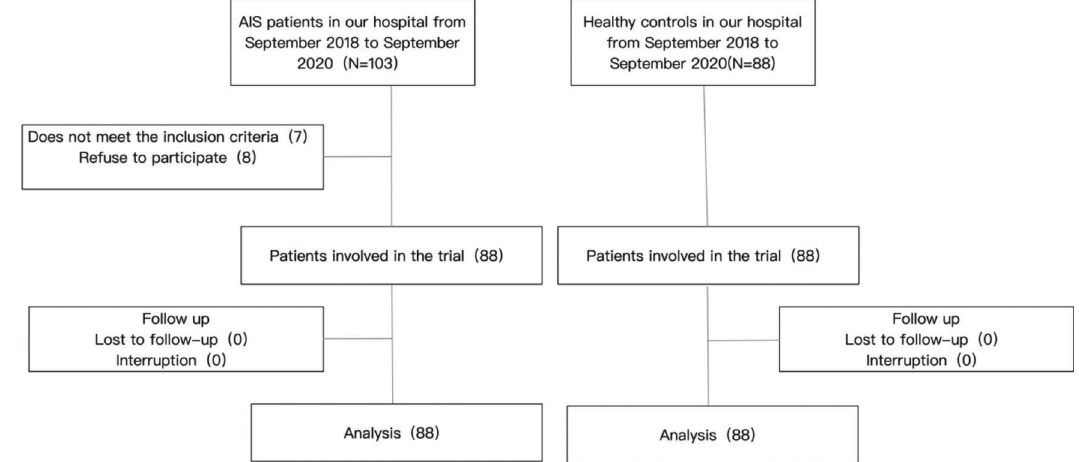
Figure 1 - Flow chart depicting patient inclusion and